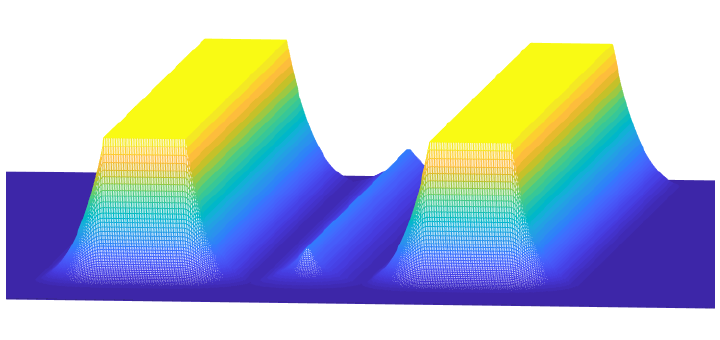
Figure 9. Potential of boundary and